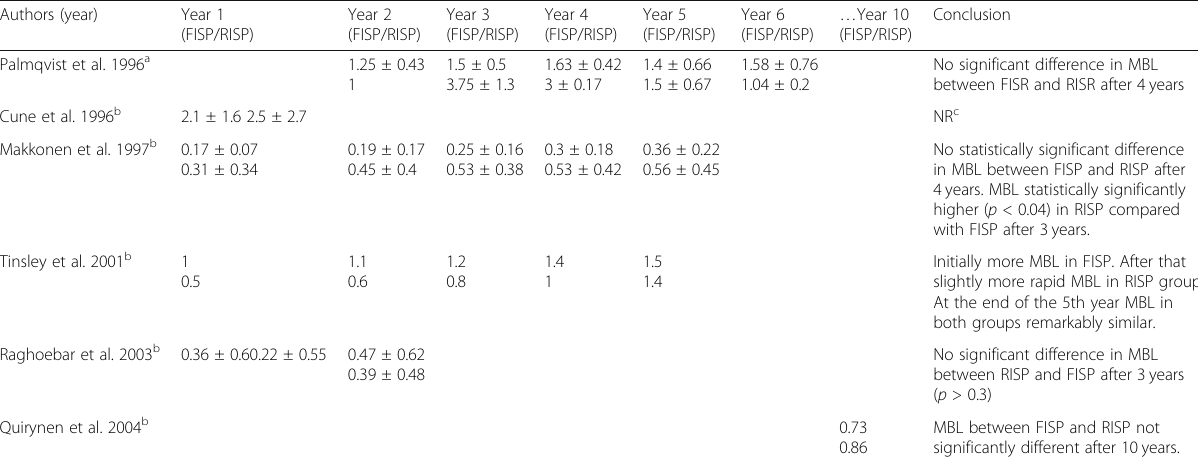
Table 6 MBL outcomes (FISR versus RISR) in the included studies